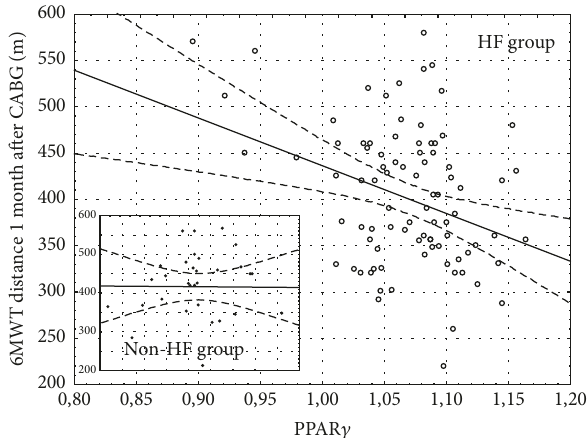
Figure 2: 6MWT distance 1 month after CABG was negatively correlated with PPAR 𝛾 only in patients with HF during follow-up ( 𝑅 = −0.24 ; 𝑝 < 0.05 ).